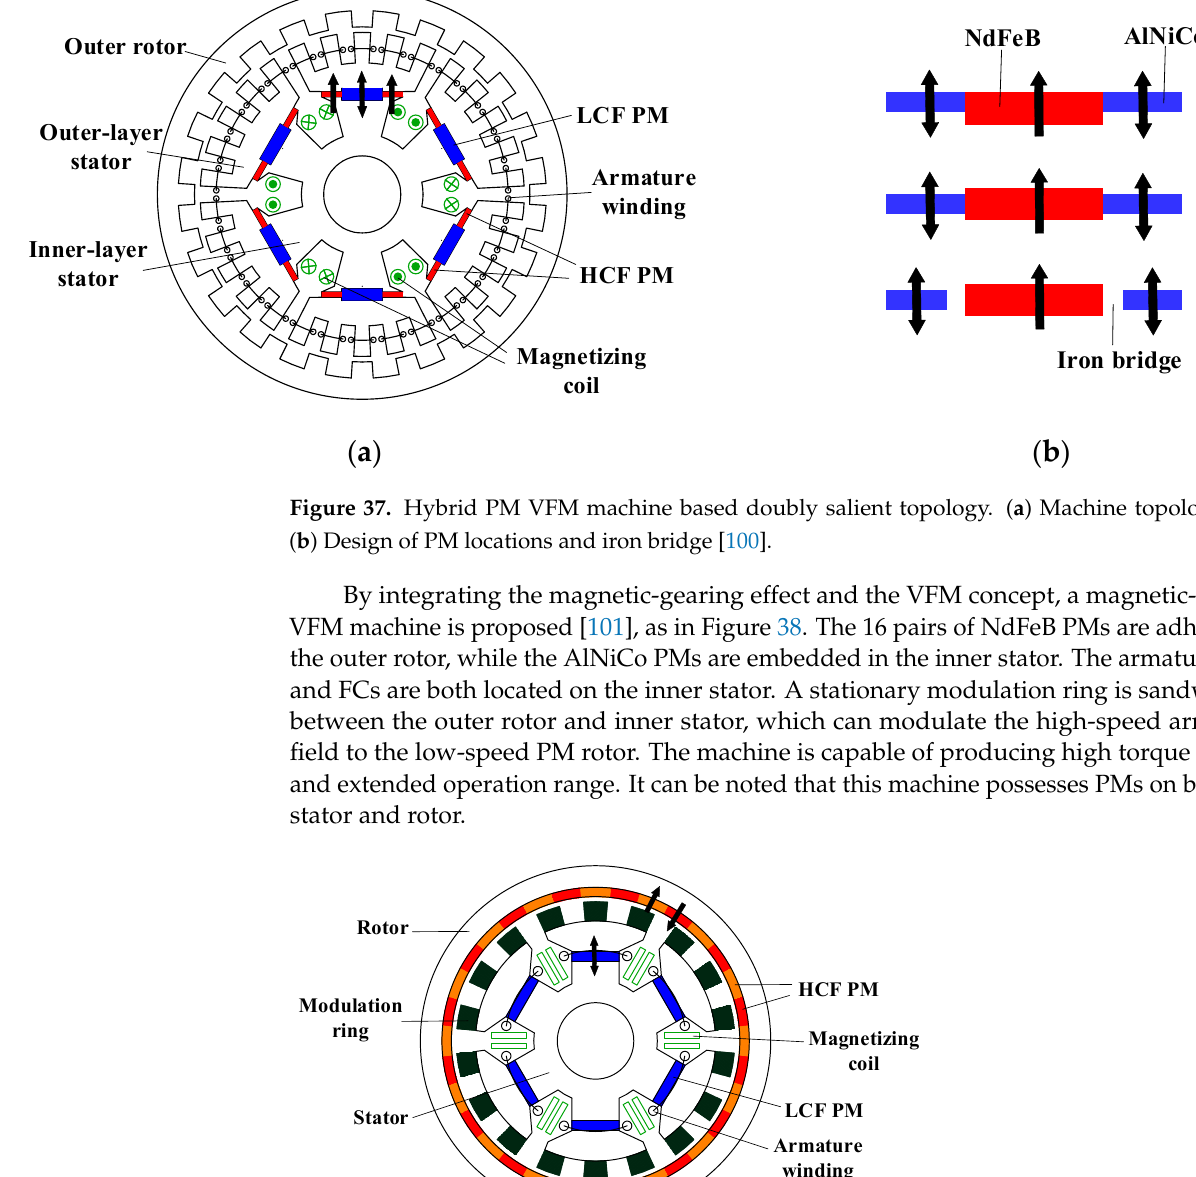
Figure 38. Hybrid PM VFM machine based on magnetic ‐ gearing topology [101].